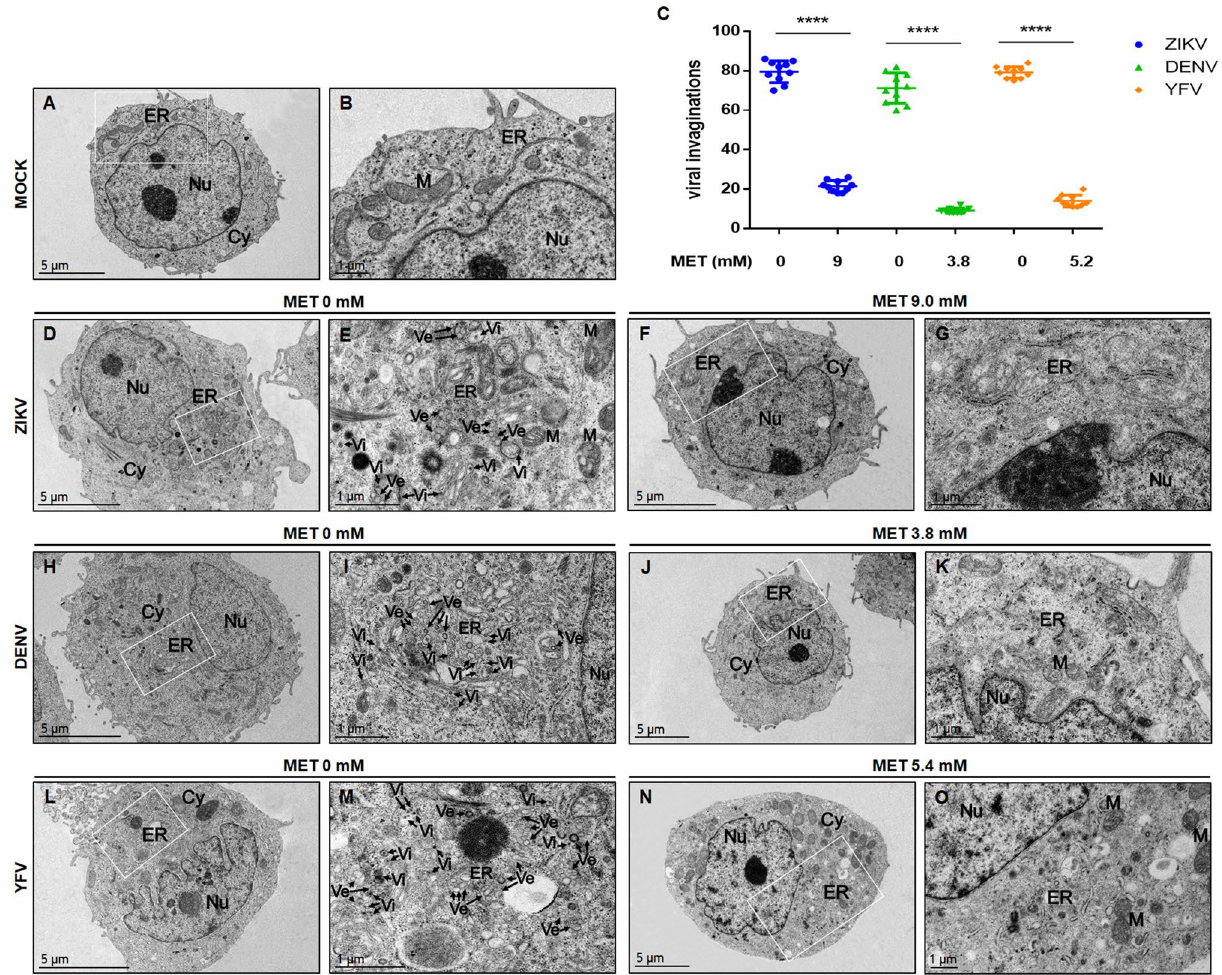
Figure 5. MET reduces the formation of structures associated with the replication complexes of flaviviruses in Huh-7 cells. Transmission electron microscopy of Huh-7 cells infected with mock ( A , B ), ZIKV ( D , E ), DENV ( H , I ), YFV ( L , M ) and treated with MET ( F , G , J , K , N , O ). Nu nucleus, Cy cytoplasm, ER endoplasmic reticulum, M mitochondria, Ve virus-induced vesicles, Vi virus-like particles. ( C ) The graph represents the Ve count of treated cells compared to untreated cells, expressed as the mean ± SD. n = 10 cells per group. **** p <